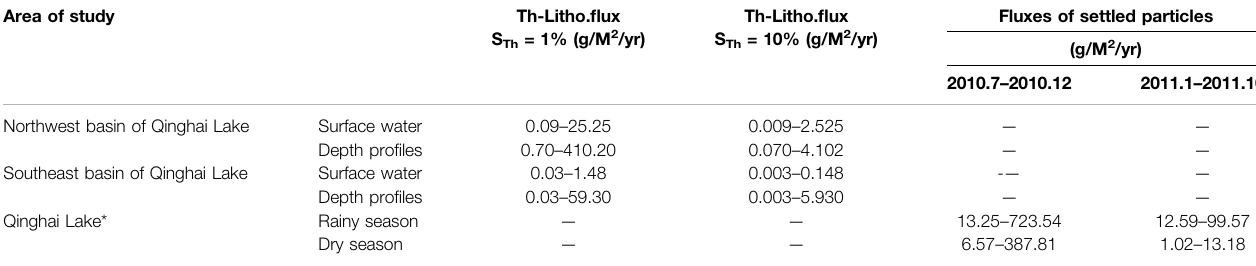
TABLE 6 | Comparison of lithogenic fl ux in the present study with the results of sediments from the study of Jin et al. (2013). Area of